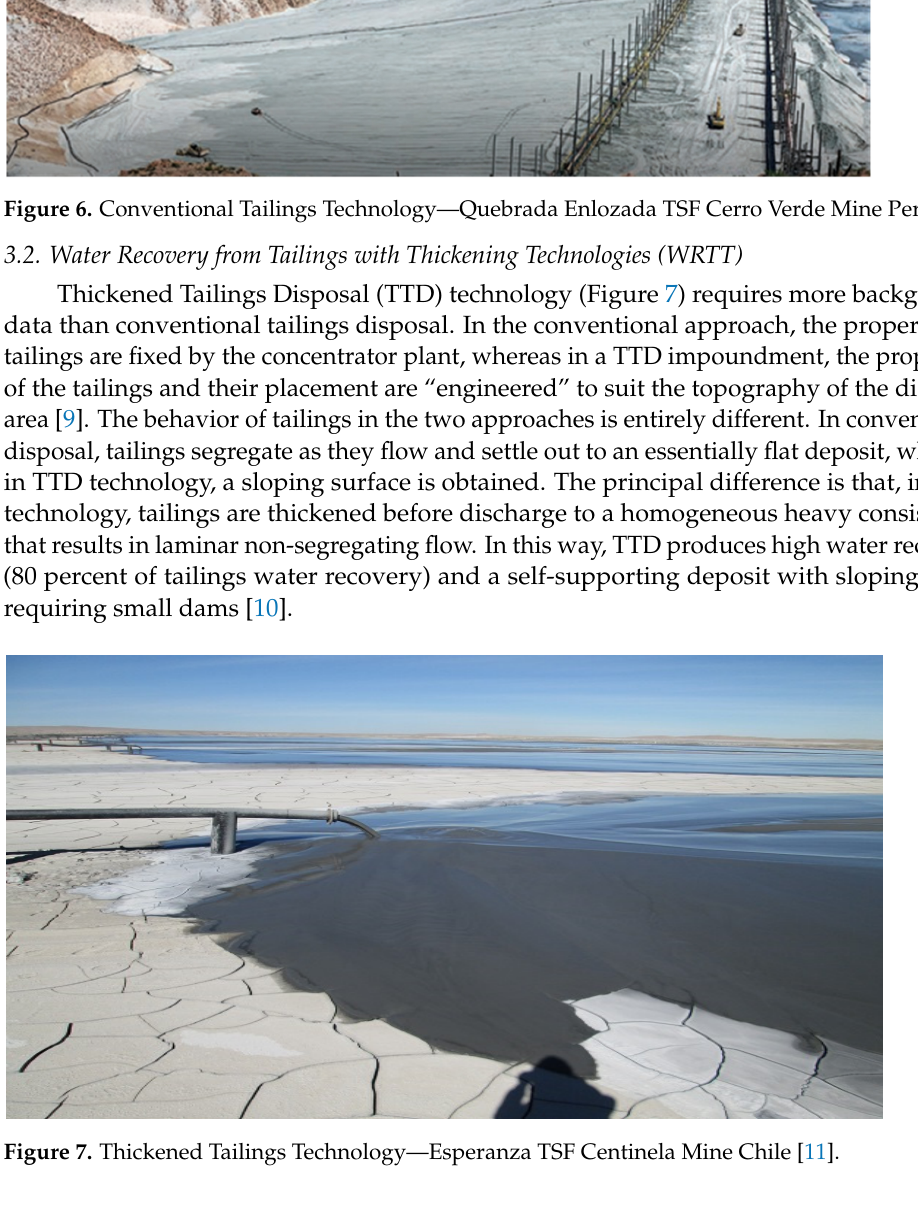
Figure 7. Thickened Tailings Technology—Esperanza TSF Centinela Mine Chile [11].